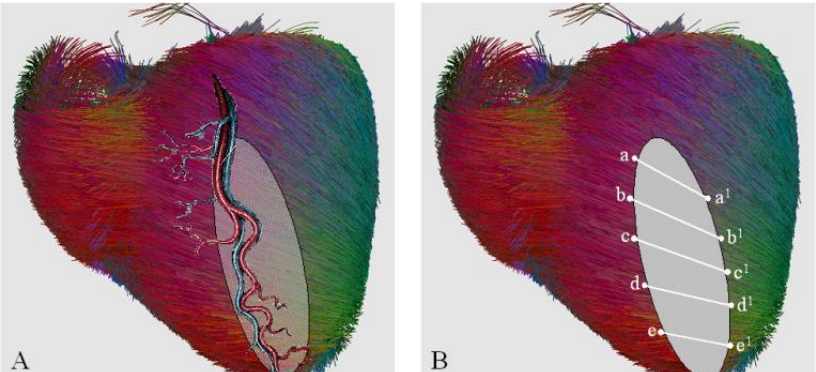
Figure 6. Coronary vessels and fiber orientation. ( A ) Epicardial course of coronary arteries crossing fiber orientation. The shaded area depicts transmural necrosis induced by coronary vessel occlusion which concerns a sector of myocardium made by several strata of differently oriented myocardial fibers. ( B ) At the border zone, still normal myocardium with still normal fiber orientation interlaces with the necrotic tissue. Necrotic tissue discontinues contiguity of myocardial fibers, although they remain normally oriented in the thickness of normal myocardium. Once fibrotic tissue is removed, the surgical suture matches the correspondent points (“a” with “a1”, “b” with “b1” etc.) restoring the contiguity of residual, normal bundles of fibers. Adapted from the reference [76]. Fiber picture was obtained by the DTI Track module of MedINRIA open source software (download at https://med.inria.fr/).